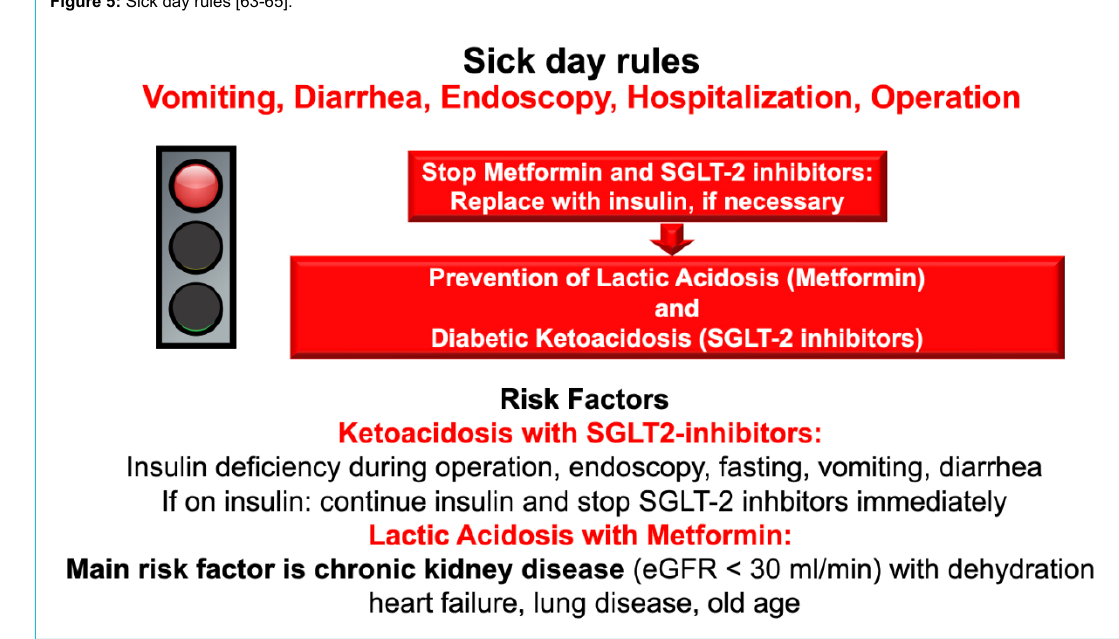
Figure 5: Sick day rules